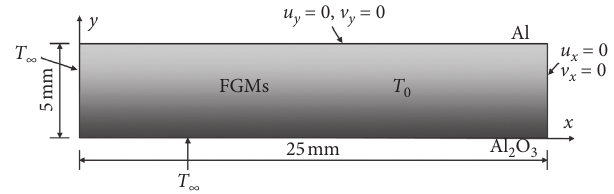
Figure 11: FGM slab in